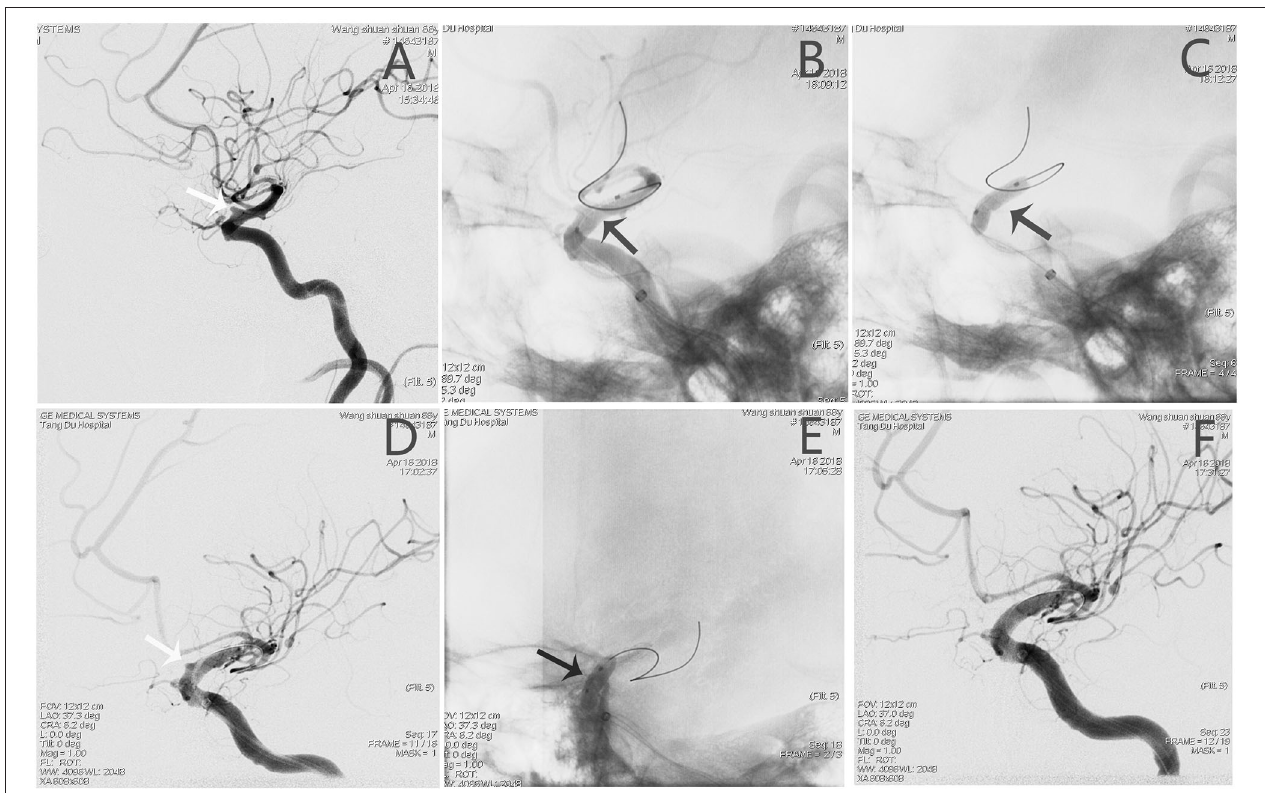
FIGURE 3 | Angiographic images of a 65-year-old man (see Patient No. 8 in Table 1 ) with a L-ICA C6 BBA. (A) A BBA (2.2*1.9mm) located on the anterior wall of the C6 segment (white arrow). (B,C) A 3.5*10-mm WCS was deployed (black arrow). (D) After re-inflation, the endoleak phenomenon remained (white arrow). (E) A 3.5*7-mm WCS was joined proximally. (F) Angiographic images showing complete aneurysm